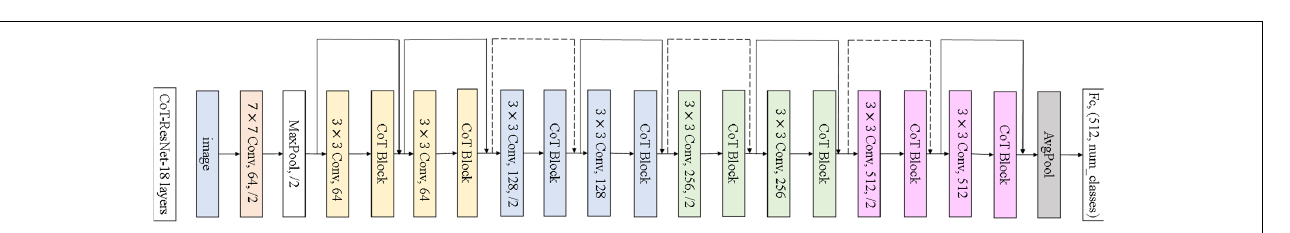
FIGURE 4 | CoT-ResNet-18 architecture